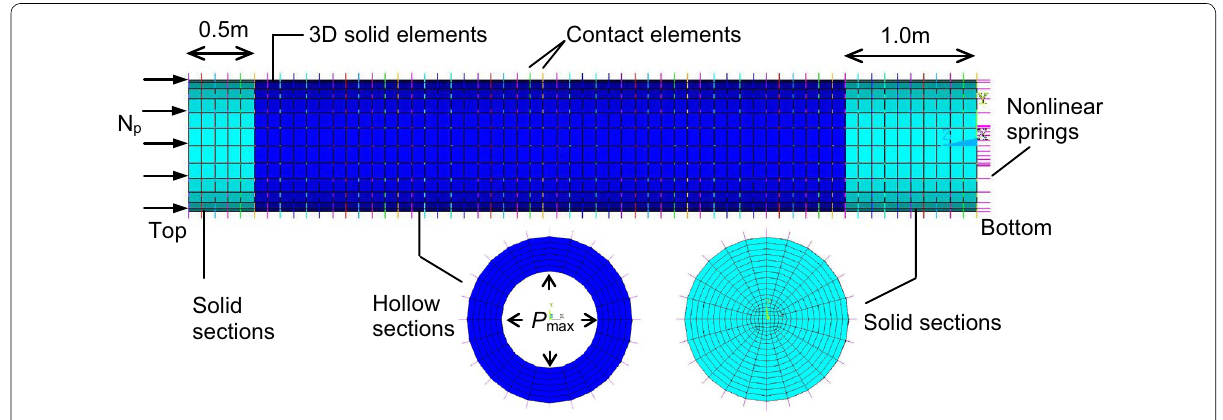
Fig. 5 Finite element model of pile